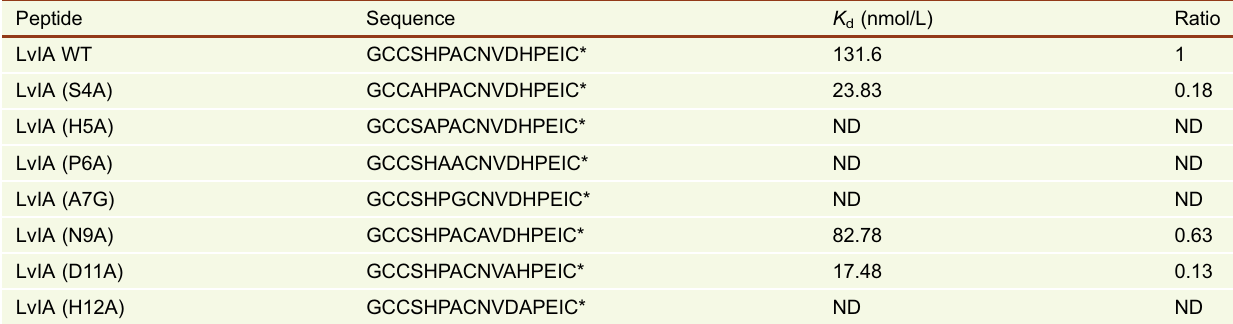
Table 2. Binding af fi nities of α -conotoxin LvIA and its mutants towards Ac-AChBP